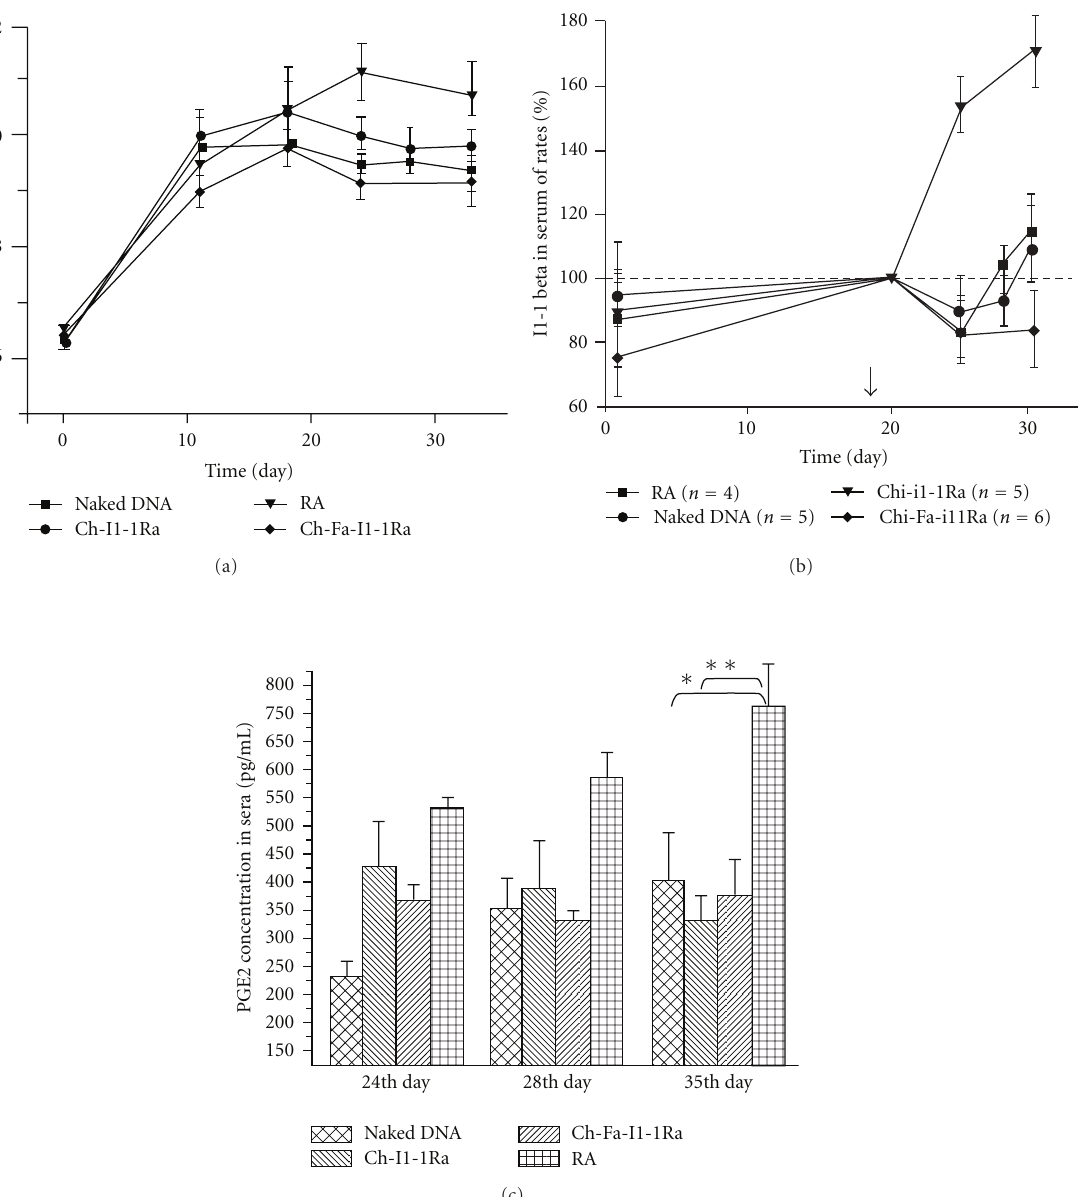
Figure 5: E ffi cacy in a rat model of arthritis. The rats were inoculated intradermally, into the plantar surface of the right hindpaw, with 0.1ml of complete Freund’s adjuvant (CFA) containing 10mgml − 1 of heat-killed Mycobacterium tuberculosis suspended in para ffi n oil.